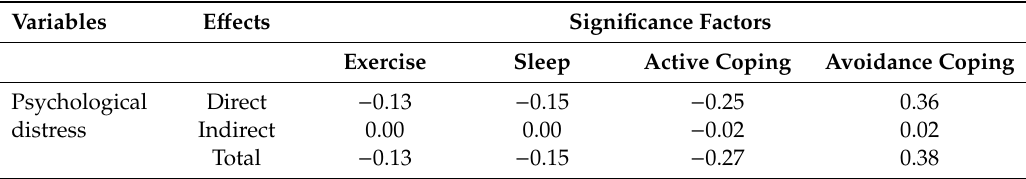
Table 3. Summary of the direct, indirect, and total e ff ects of significant factors on psychological distress among Japanese nursing